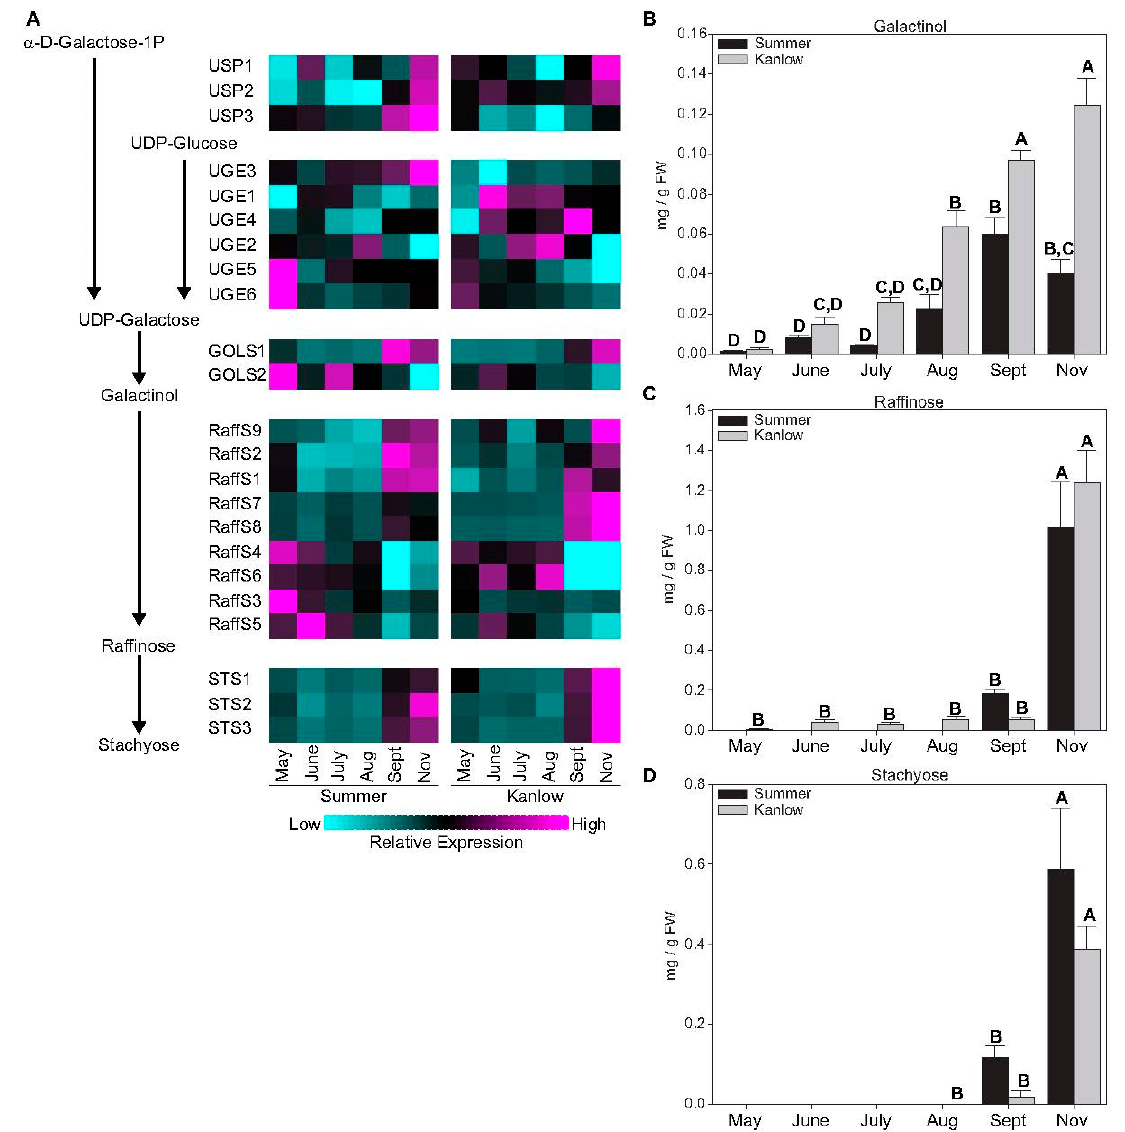
Figure 3. Genes associated with raffinose-family oligosaccharides (RFO) biosynthesis and RFO levels in rhizomes. ( A ) Abbreviated biosynthetic pathway for RFO biosynthesis and heat map of changes in expression of genes encoding the respective enzymes catalyzing each step in RFO biosynthesis. ( B ) Galactinol. ( C ) Raffinose. ( D ) Stachyose. In all panels, black bars indicate Summer, and grey bars indicate Kanlow rhizomes. Letters over each bar denote statistical significance. Error bars represent standard error. For heatmaps, cyan is low expression and magenta is high expression. Full list of genes is provided in Supplementary Data S1.